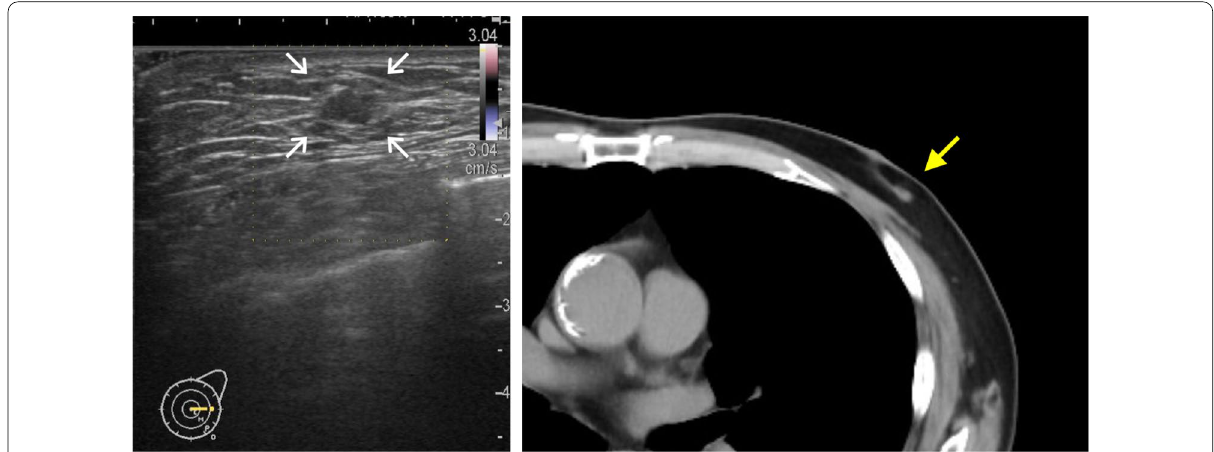
Fig. 7 Imaging findings at 8 months after the disappearance of the tumor. Ultrasonography and CT revealed the reappearance of a 0.6-cm-diameter breast tumor in the same place as the previous mass